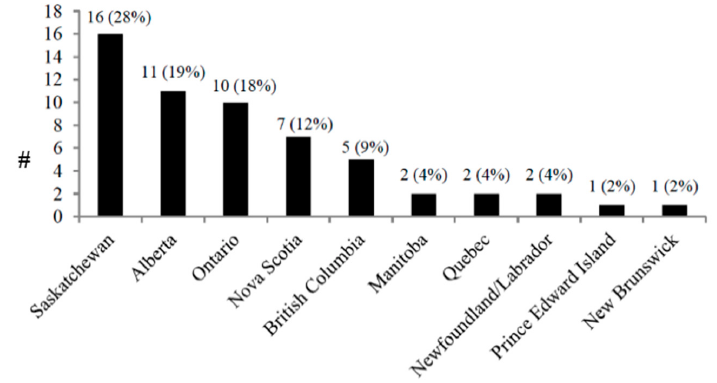
Figure 1. Responses by province ( n = 67).